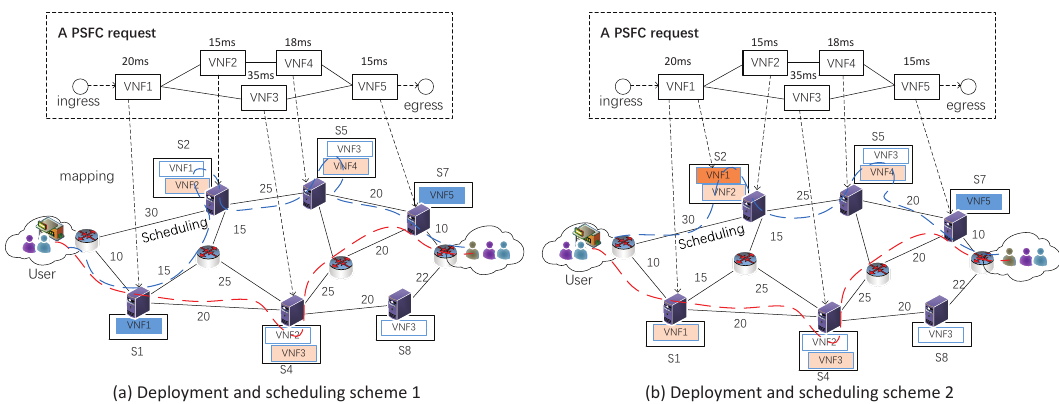
Figure 4. Traffic scheduling of PSFC. The white, blue, orange, and red boxes represent the idle VNFs, shared VNFs, occupied VNFs, and additional VNFs,